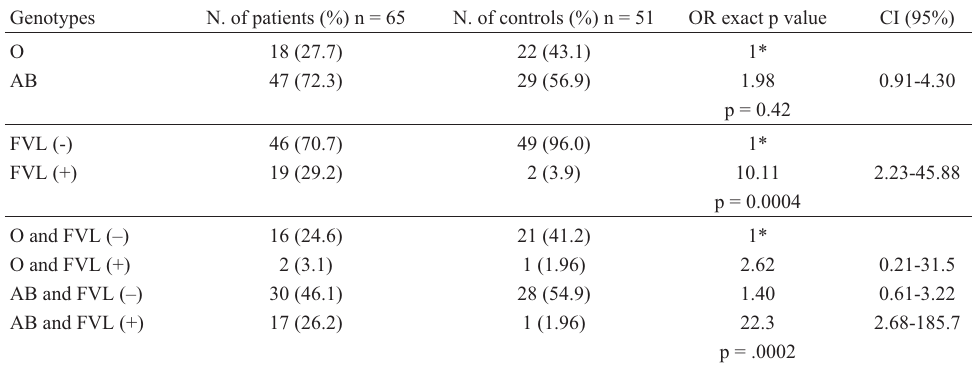
Table 1 - Combined risk of thrombosis for ABO and FVL genotypes.